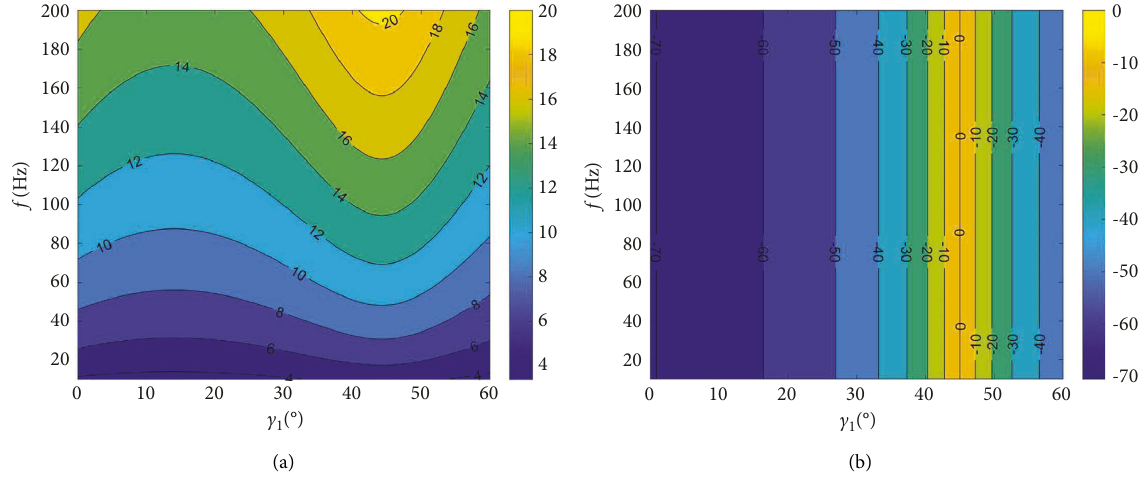
Figure 6: Contours of evaluated v SV and θ 0 when mean values of parameters are taken. (a) v SV and (b) θ 0